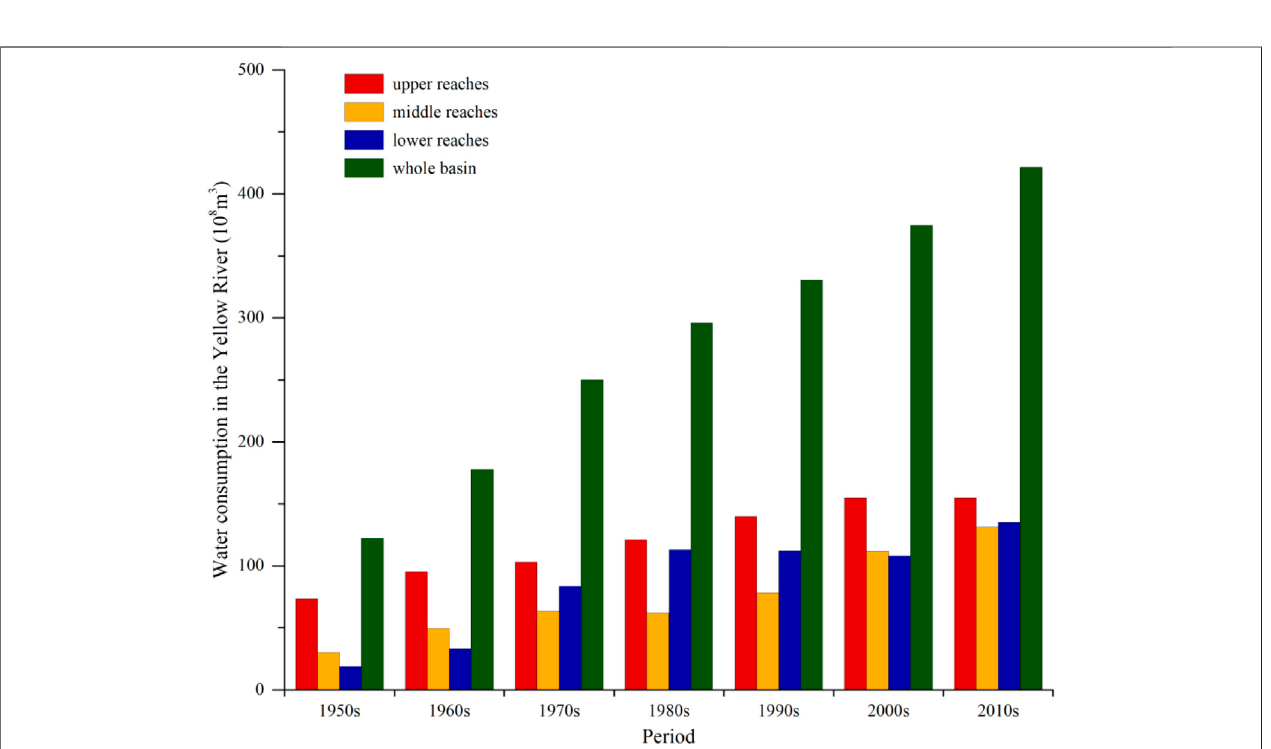
FIGURE 7 | Water consumption in the Yellow River basin during different periods since 1950s.